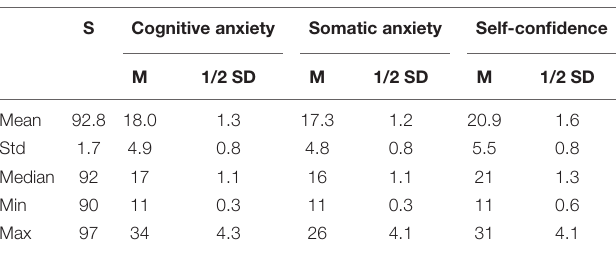
TABLE 1 | Overall descriptive statistics for CSAI-2 Subscales.